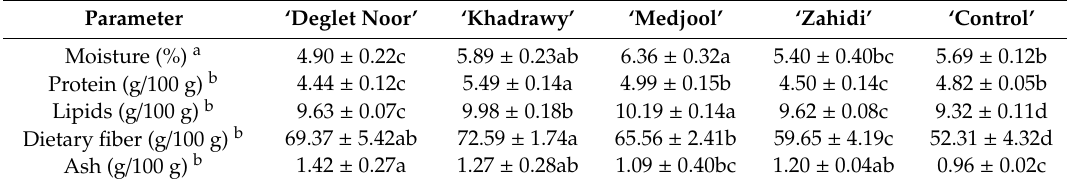
Table 2. Proximate composition of ‘Medjool’ date seeds obtained from fruit resulting from pollination using pollen from ‘Deglet Noor’, ‘Khadrawy’, ‘Medjool’, and ‘Zahidi’ cultivars. Control is a pollen mixture from random date palm male plants used by the grower.